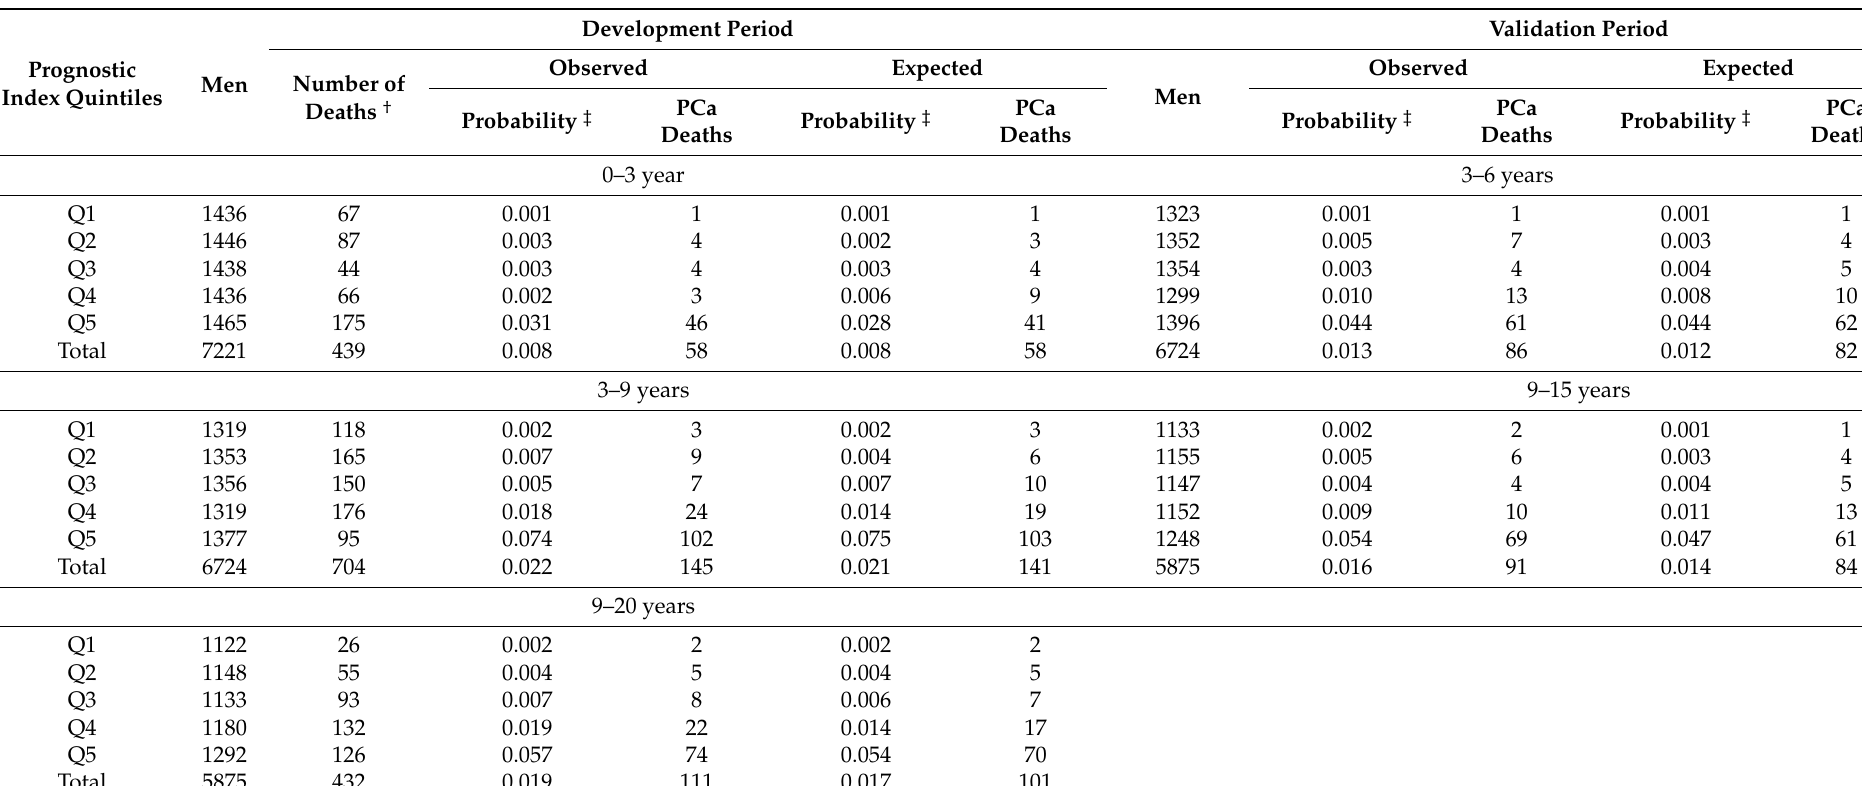
Table 2. Expected and observed probability and number of PCa deaths in the development and validation periods for quintiles of prognostic index.